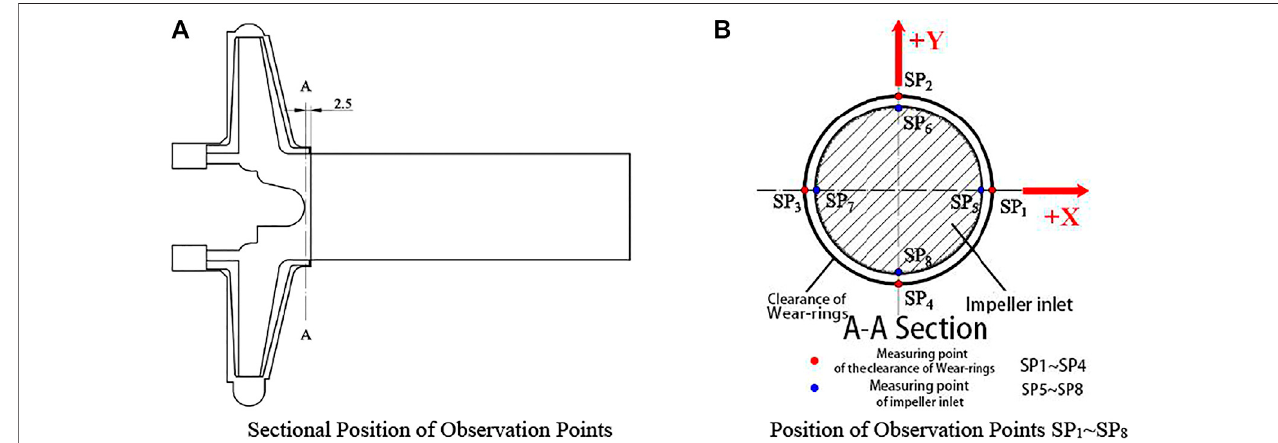
FIGURE 9 | Diagram of position of observation points for wear-ring pressure pulsation. (A) Sectional position of observation points. (B) Position of observation points SP 1 ~SP 8 .